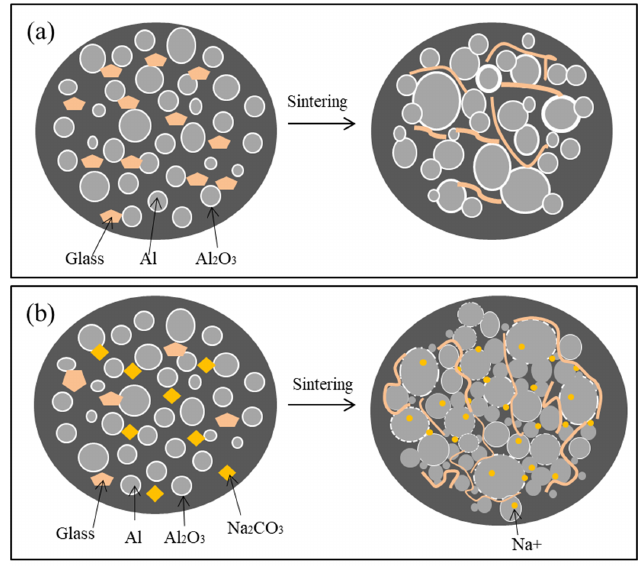
Figure 13. Model diagram of conductive mechanism enhanced by addition of sodium carbonate. ( a ): Sintering without addition of sodium carbonate; ( b ): Sintering with addition of sodium car- bonate.